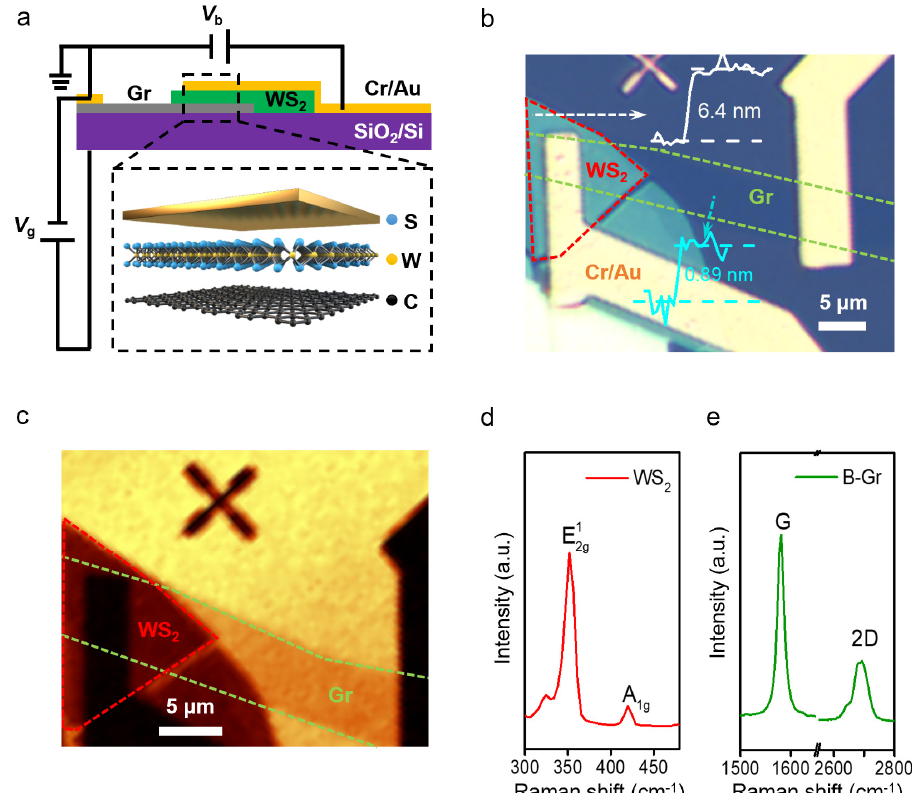
Figure 1. Characterizations of the GWMHs tunneling devices. ( a ) Schematics of the GWMHs tunneling device with the crystalline structure of each layer shown in an enlarged view. The WS 2 layer is sandwiched by the graphene and metal electrode. Bias voltage ( V b ) is applied between the bottom graphene and the top Cr/Au electrode; gate voltage ( V g ) is applied between the bottom graphene and the SiO 2 /Si substrate. ( b ) Optical microscopy image of the GWMHs tunneling device. The graphene and WS 2 layers are marked with green and red dash lines. The inset white line and cyan line show the thicknesses of the WS 2 layer and the graphene layer which were determined by AFM to be about 6.4 and 0.89 nm, respectively. ( c ) Scanning Raman mapping of integrated intensity of Si (peak position: 520 cm − 1 , integration width: 20 cm − 1 ) showing the shapes of the heterojunction. The green and red dashed lines mark the position of the WS 2 and graphene layers, respectively. ( d , e ) Raman spectra of WS 2 and graphene,